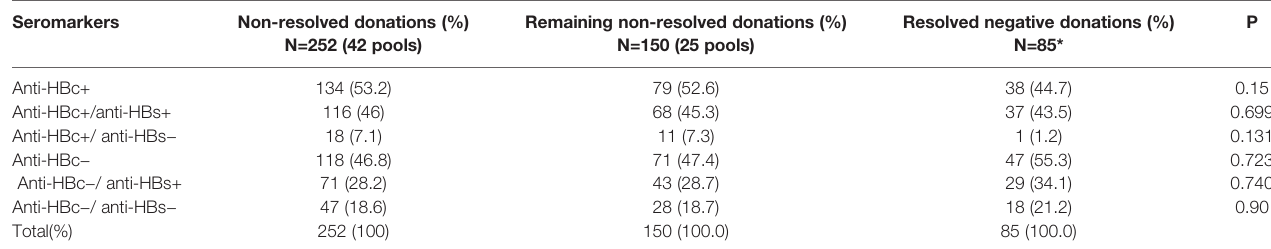
TABLE 3 | HBV seromarker distribution of non-resolved donations, the remaining non-resolved and resolved negative donations. Seromarkers